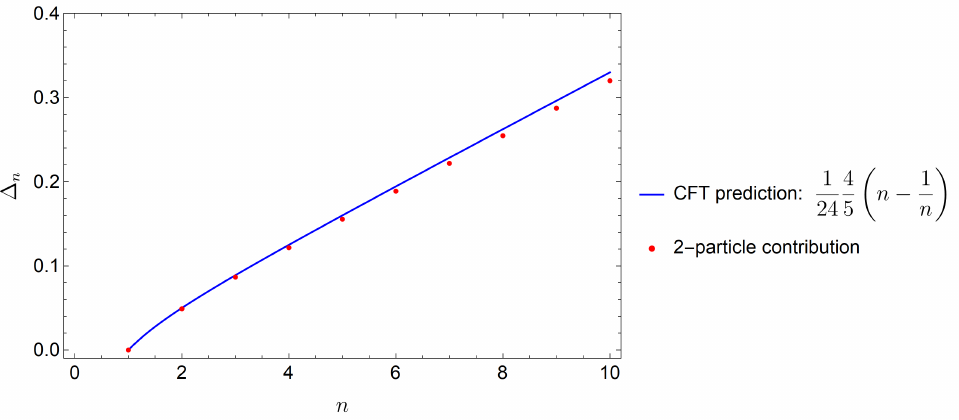
Figure 4 . Conformal dimension of the BPTF T n as obtained from the ∆ -theorem (red dots) compared to the exact CFT formula (blue dots).